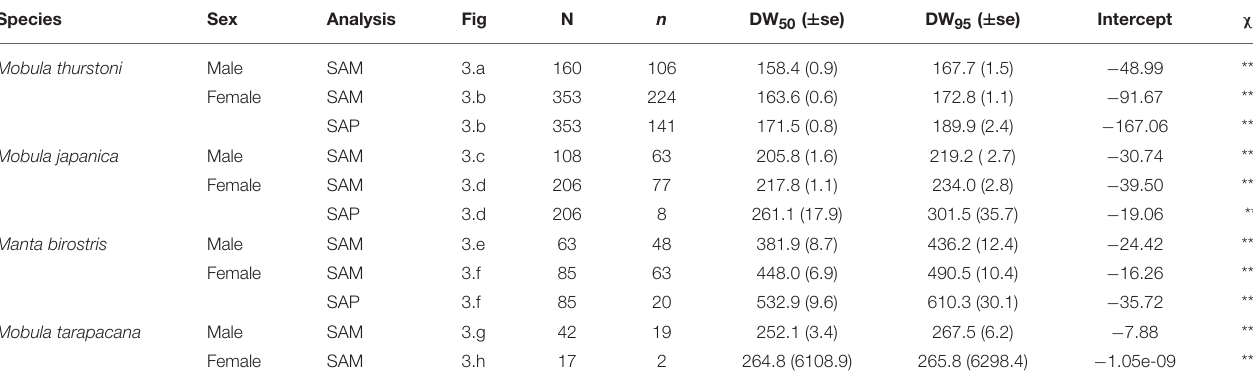
TABLE 5 | Maturity and pregnancy ogives parameters for Mobula thurstoni , Mobula japanica , Manta birostris , and Mobula tarapacana . Species Sex Analysis Fig N n DW 50 ( ± se) DW 95 ( ± se) Intercept χ ² Mobula thurstoni Male